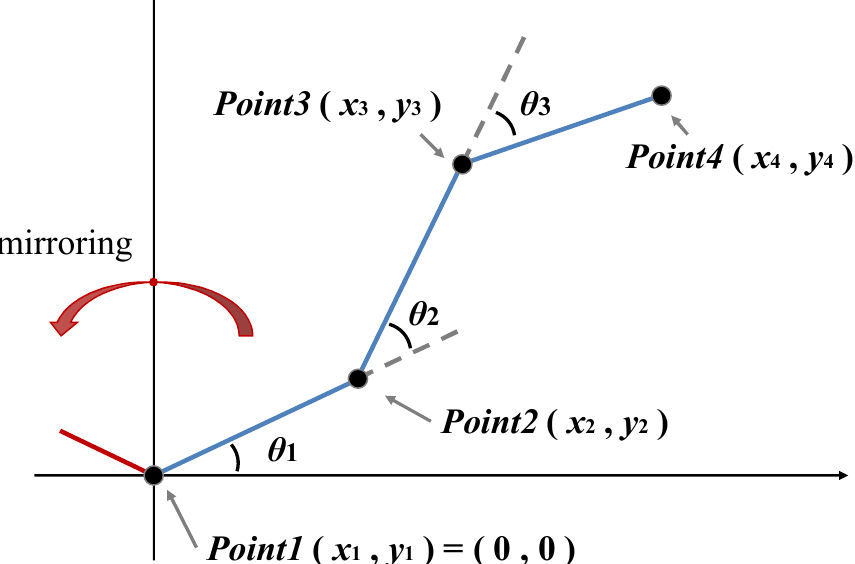
Figure 11. Generation method of cross-section.